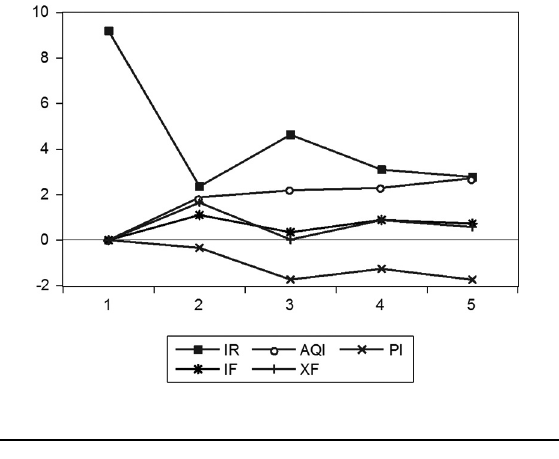
Variance decomposition of